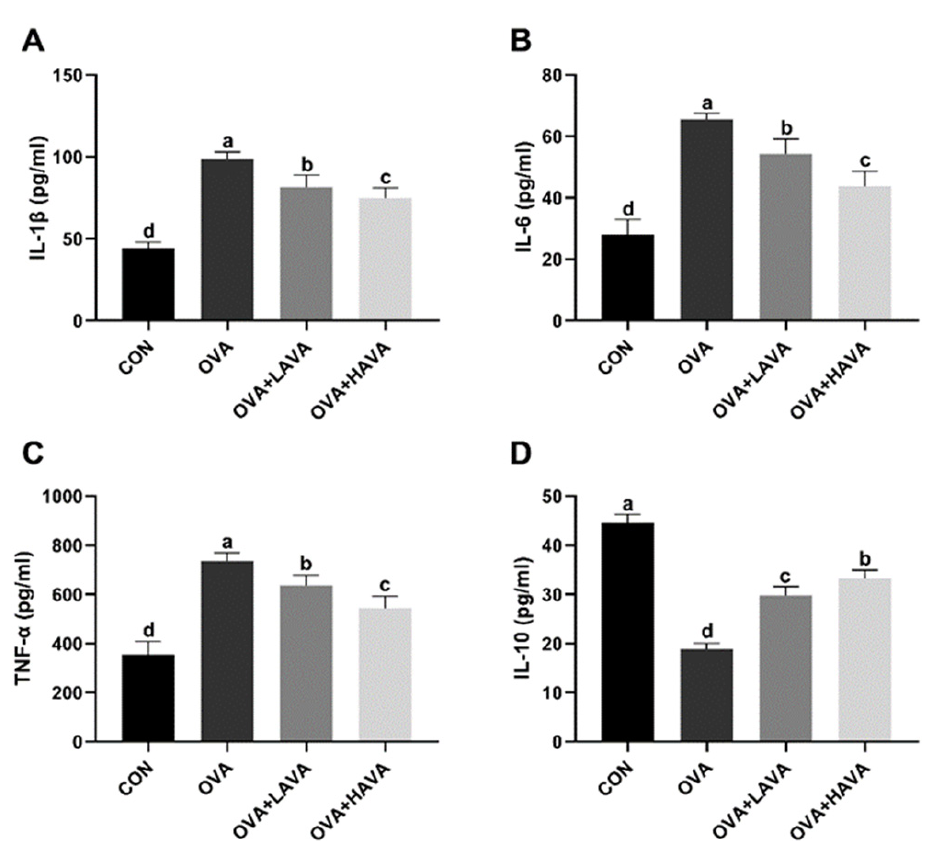
Figure 2. The anti-inflammatory effect of avenanthramide (AVA) in ovalbumin (OVA)-induced food allergy mouse model in experiment 1. ( A – C ) Pro-inflammatory cytokines including interleukin-1 β (IL-1 β ), IL-6, and tumor necrosis factor- α (TNF- α ) in the serum, ( D ) the anti-inflammatory factor IL-10 in the serum. CON: the control group; OVA: mice orally challenged with OVA; OVA + LAVA: an OVA challenged group that was oral gavaged with a low dose of 10 mg/kg bw AVA; OVA + HAVA: an OVA challenged group that was oral gavaged with a high dose of 20 mg/kg bw AVA. Results are presented as means ± SDs ( n = 8). Bars with no letter in common are significantly different, p ≤